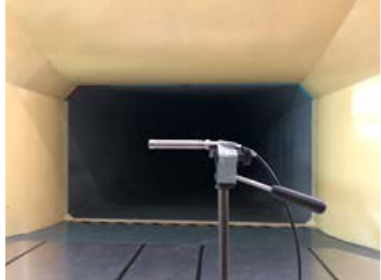
Figure 5. Measuring site of the background noise.